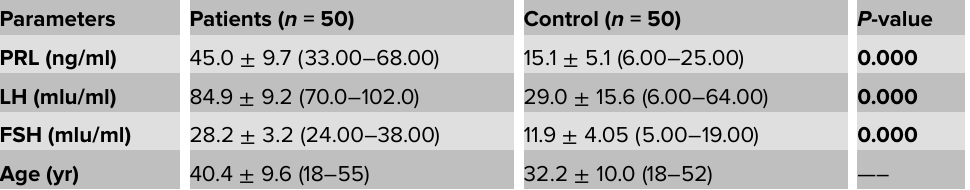
TABLE 1: The (mean ± SD) of serum PRL, LH, FSH and age in the study population.